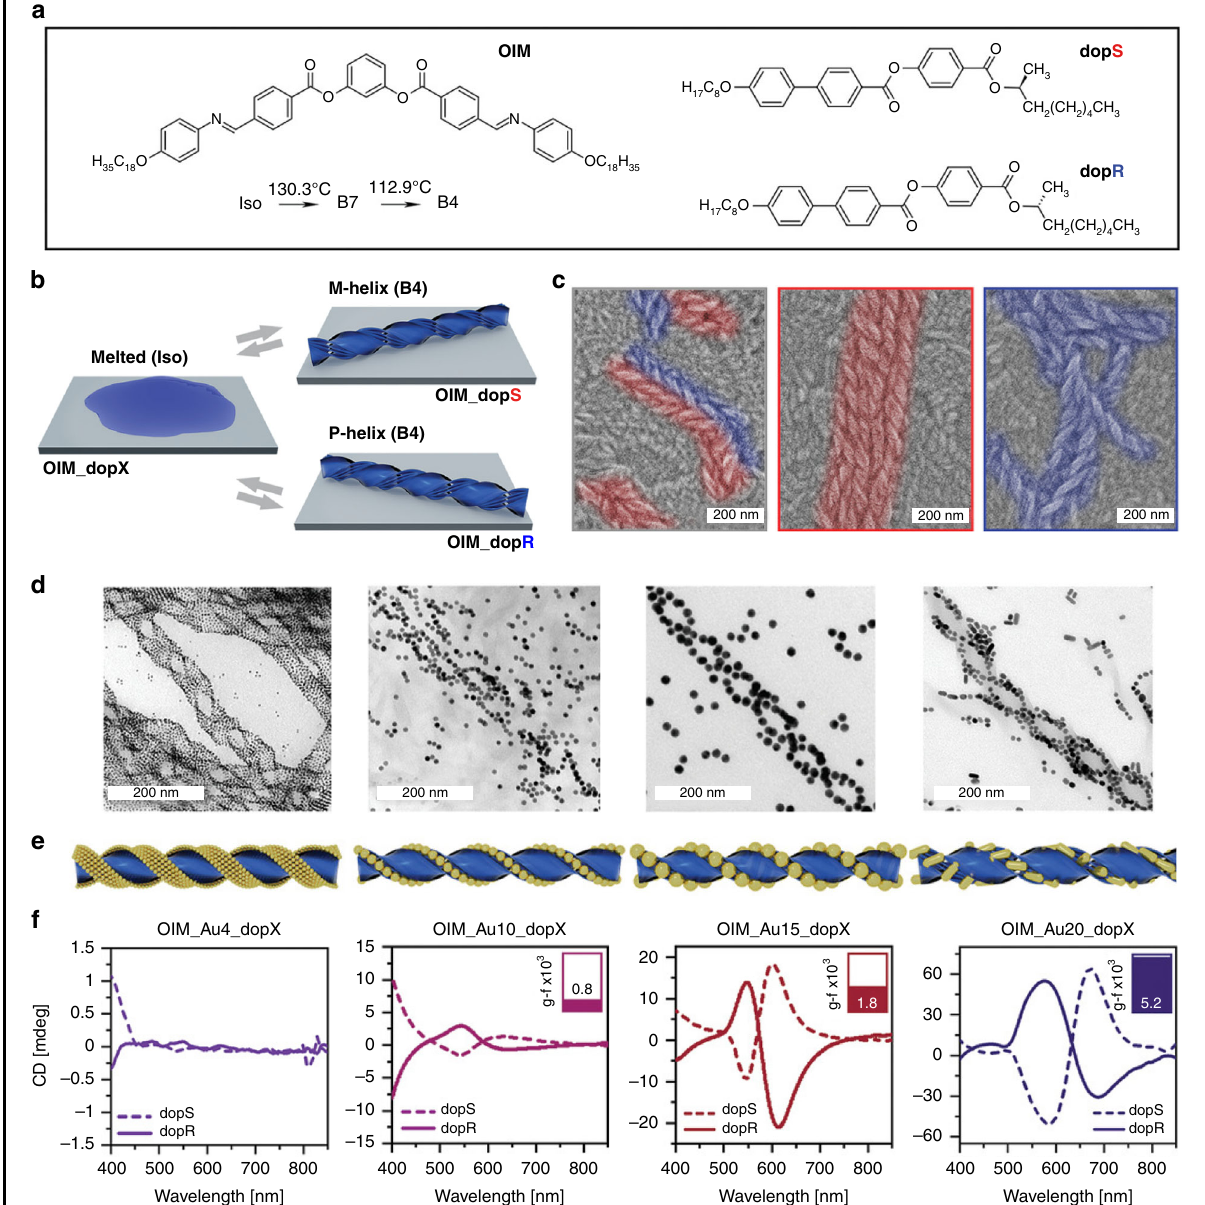
Fig. 5 Thermotropic liquid crystal-templated chiral plasmonic nanomaterials. a Molecular structures of liquid crystal matrix (OIM) and chiral dopants (dopS and dopR). b Schematic formation of left-handed (M-type) and right-handed (P-type) chiral nanomaterials. c SEM images showing M- and P-helices formed in pure liquid crystal matrix, dopR-doped liquid crystal and dopS-doped liquid crystal, respectively; P-helices and M-helices are colored in blue and red, respectively. d – f TEM images, 3D models, and corresponding CD spectra of chiral nanomaterials prepared using 4, 10, and 15 nm spherical gold nanoparticles, and 8 × 20 nm gold nanorods. Reproduced with permission from ref. 190 . Copyright 2022,